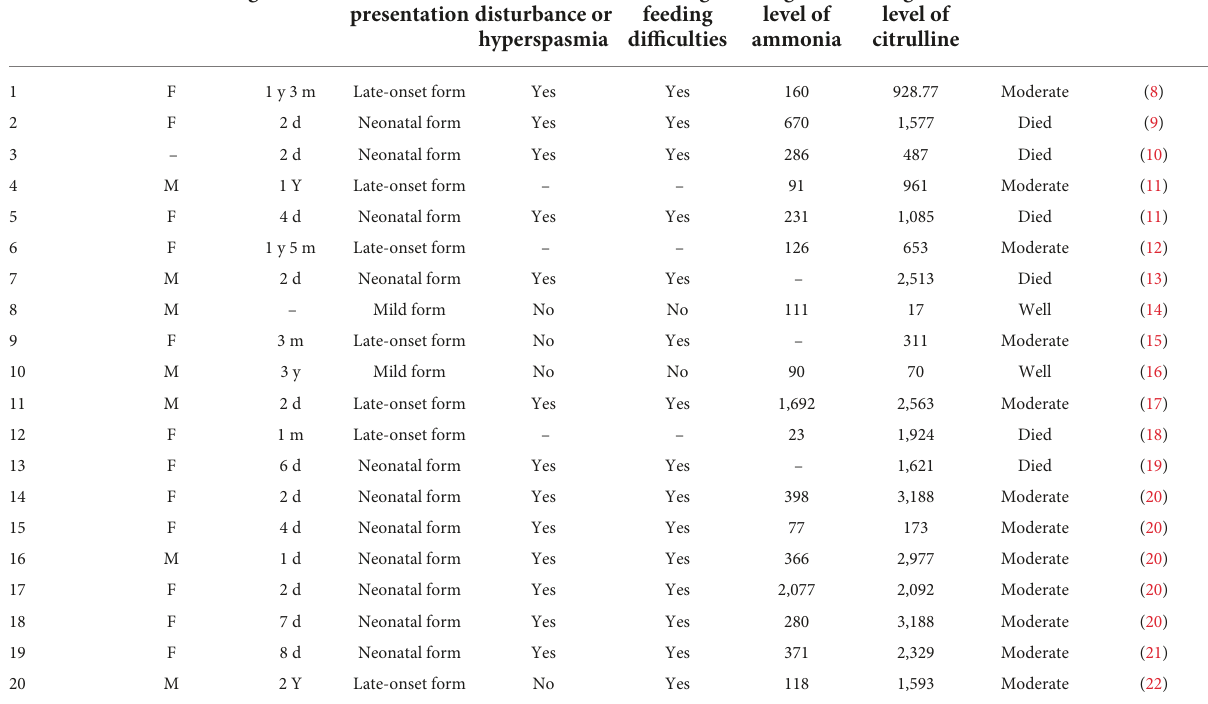
TABLE 5 Clinical presentations and biochemical investigations of patients described in the literature. Patient no.